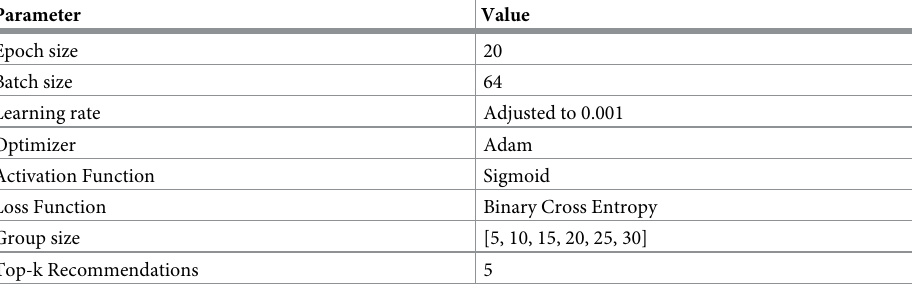
Table 12. Values of parameters in the proposed model.